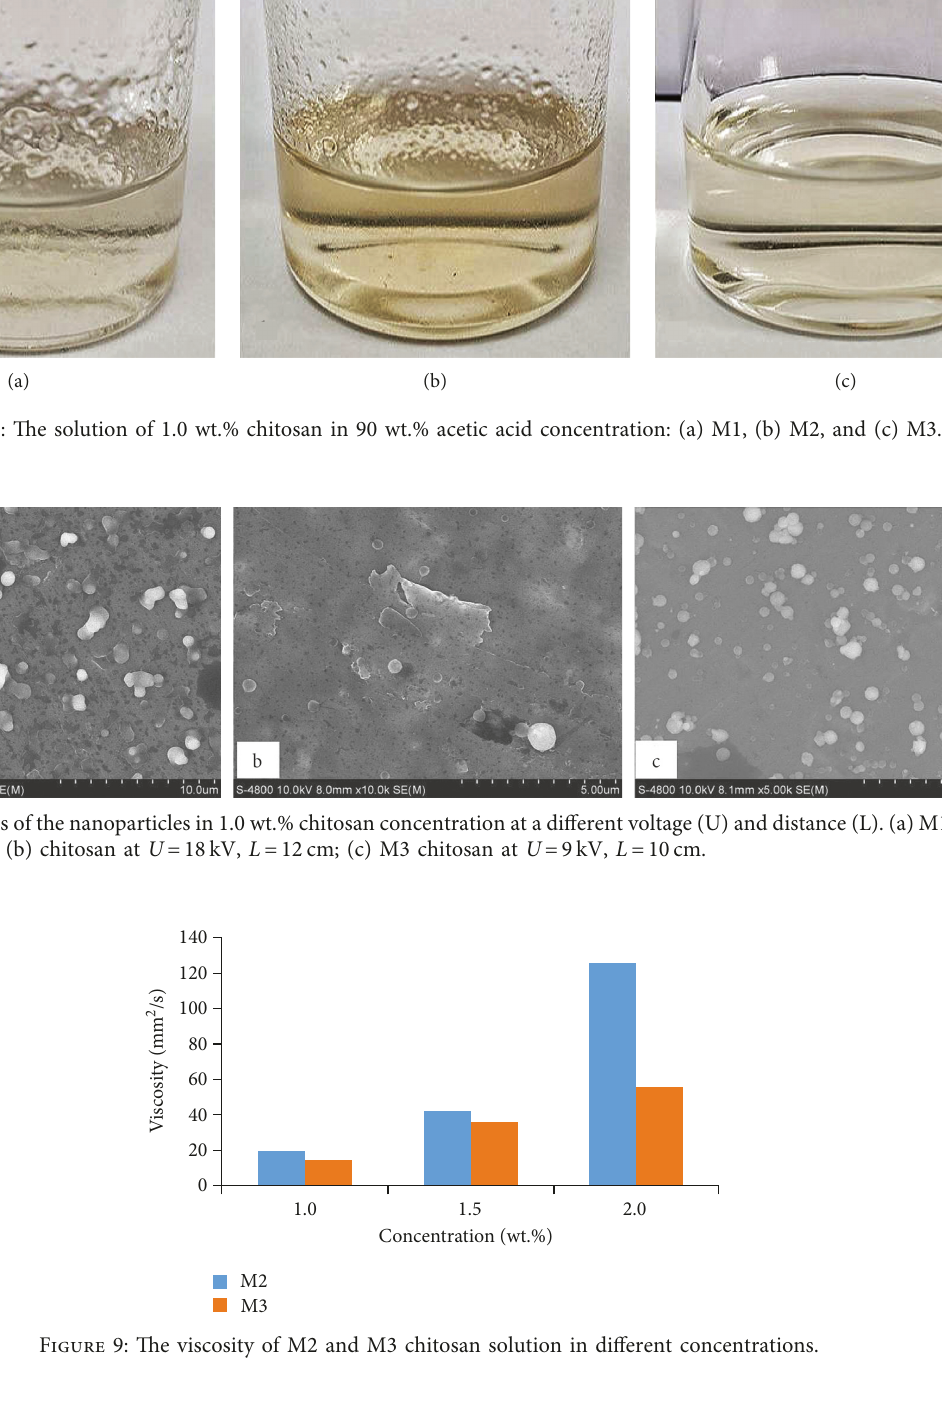
uniform at U 12kV and L 10cm with the average diameter (cid:30) (cid:30) of 338nm in Figure 13. This size completely meets the re- quirement of nanoparticles for drug delivery systems.